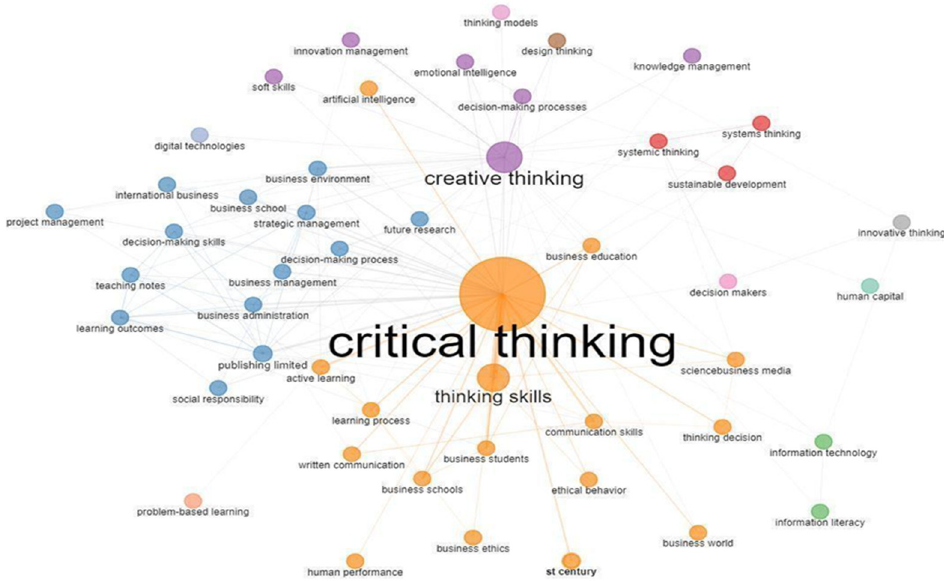
Figure 7. Co-occurrence network. Source: Created by the authors through Bibliometrix.